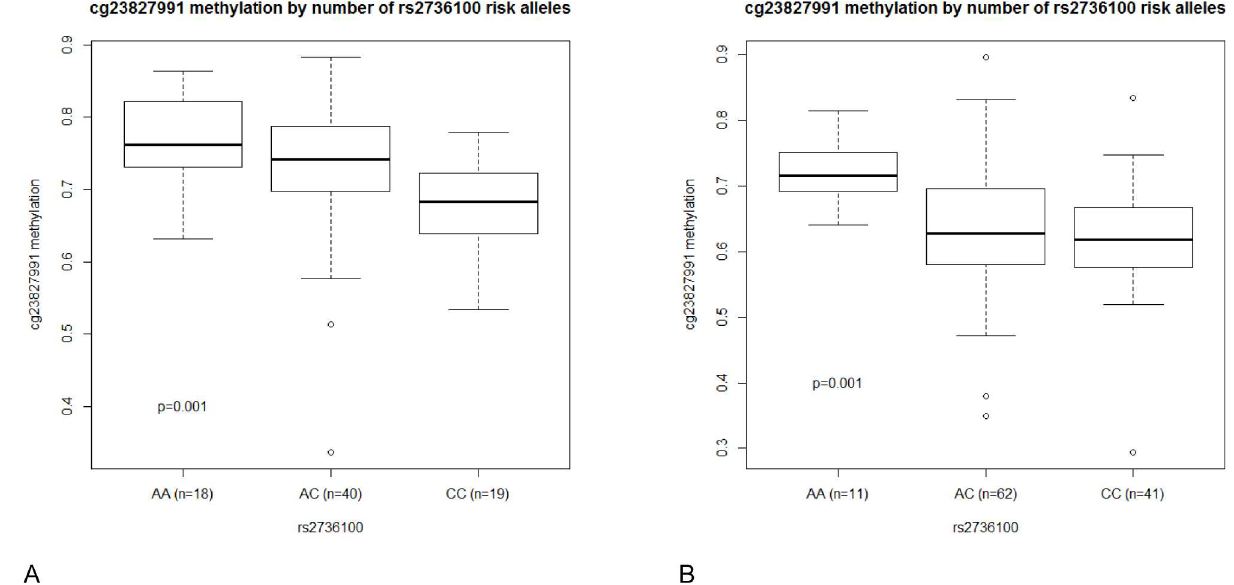
Fig 3. Levels of cg23827991 methylation by rs2736100genotype. (A) 77 glioma tumors (the pilot dataset) and (B) 115 TCGA glioblastomatumors analyzedon the 450 k methylation array.